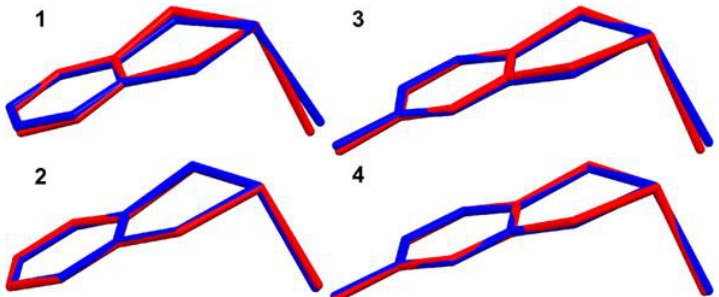
Figure 6. Graphical presentation showing the overlay of the molecular structures derived from DFT calculation (red) and experiment (blue) for AsI(PhS 2 ) ( 1 ) (RMSD = 0.146 Å ), AsBr(PhS 2 ) ( 2 ) (RMSD = 0.042 Å ), AsI(MePhS 2 ) ( 3 ) (RMSD = 0.111 Å ), AsBr(PhS 2 ) ( 4 ) (RMSD = 0.041 Å ).